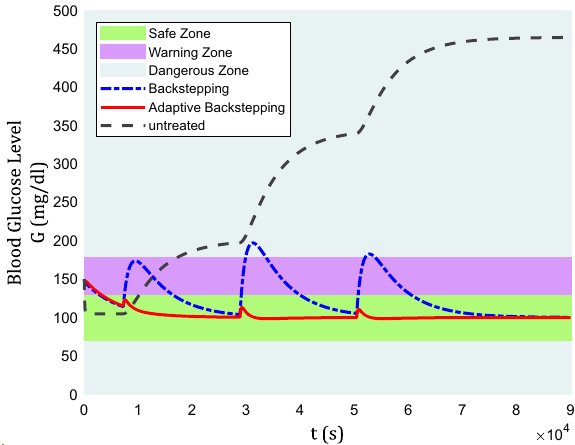
Figure 3. Blood glucose level for a nominal patient under the control algorithm.